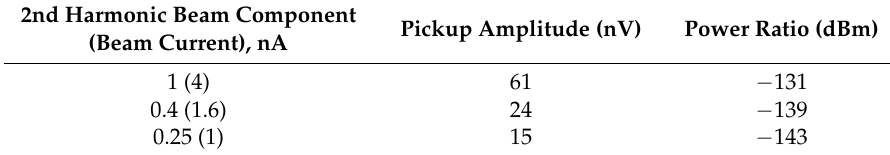
Table 4. Expected pickup voltage for second harmonic component of the beam current. The beam current is denoted in